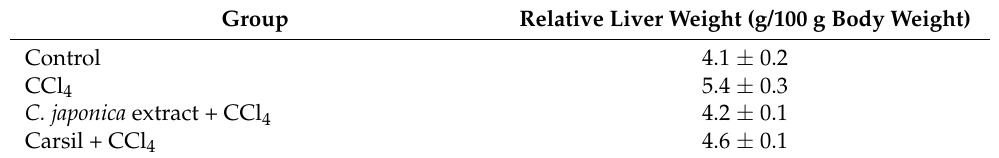
Table 6. Relative liver weight of CCl 4 -treated rats with and without the gavage of C. japonica extract.